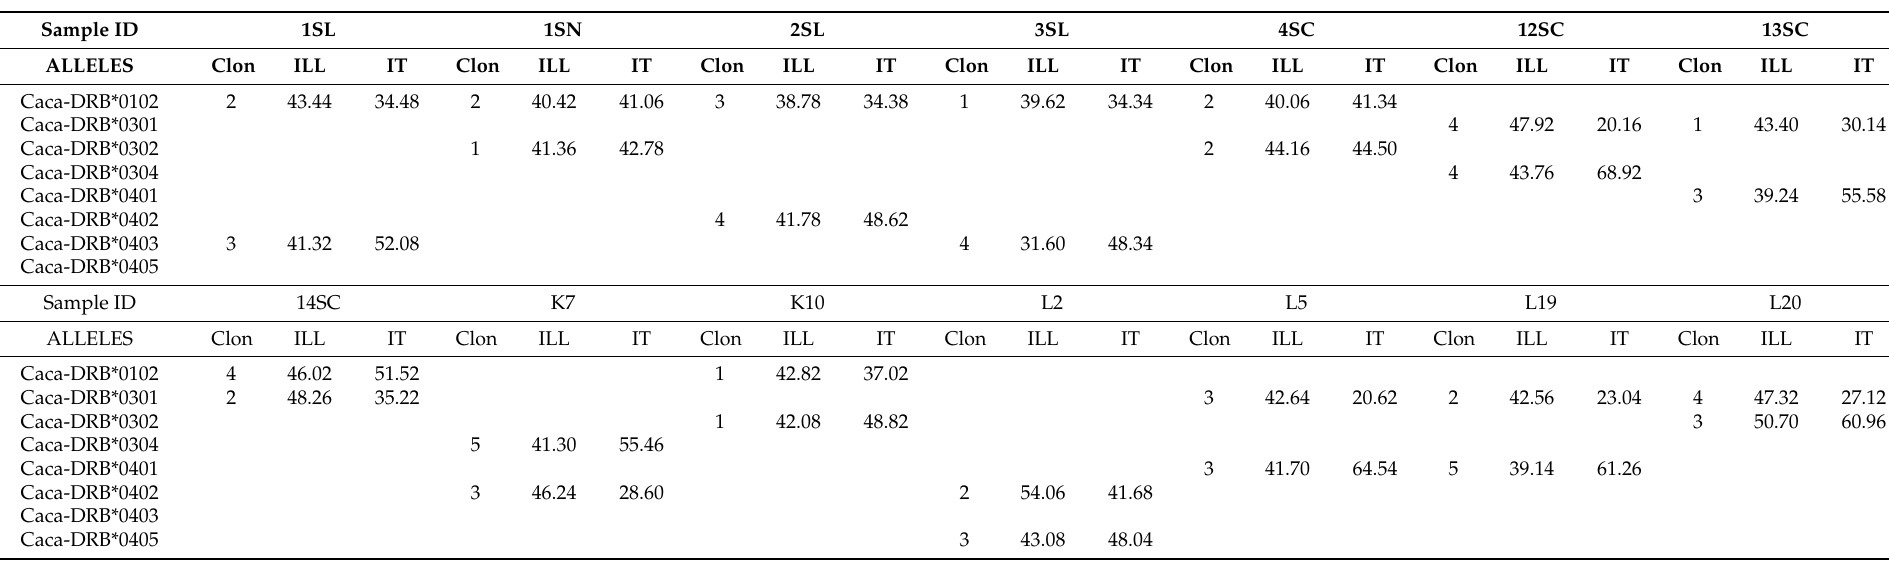
Table 1. Number of detected sequences with molecular cloning (Clon) and frequencies of reads corresponding to each allele (%) obtained using AmpliSAS web version after Illumina (ILL) and Ion Torrent (IT) sequencing of 14 European roe deer at the MHC-DRB